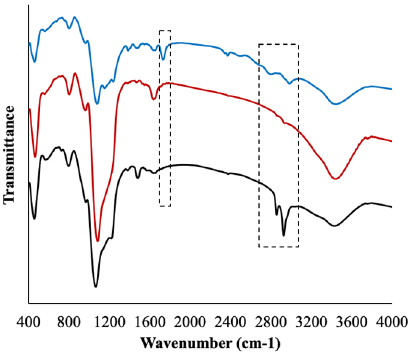
Figure 1. The Fourier-transform infrared (FT-IR) spectra of the nanoparticles: (black line) MSNs with the template, (red line) CTAB free initiated MSNs, (blue line) MSNs–PDEAEMA.